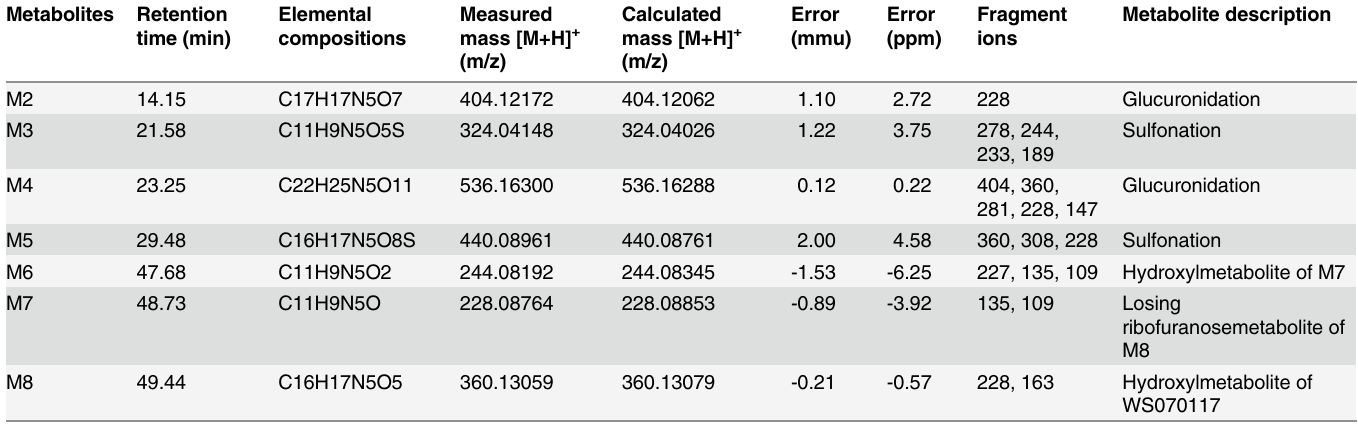
Table 1. The retention time, predicted elemental compositions, observed mass and calculated mass, characteristic fragment ions, and description of metabolites of WS070117 in rat urine. Metabolites Retention time